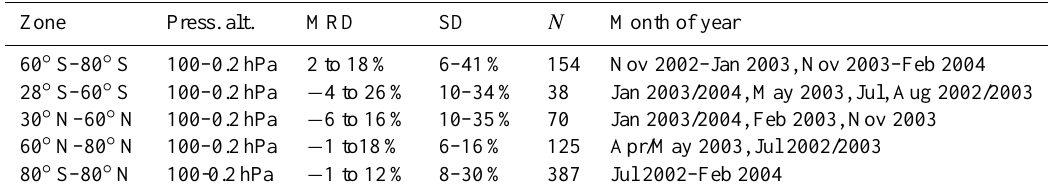
Fig. 13. Mean relative deviation (including the standard error of the mean) of H 2 O profiles as measured by MIPAS and HALOE in the Northern (left) and Southern (right) Hemispheres for different latitude regions (red solid lines) from 60–80 ◦ N (top left), 30–60 ◦ N (bottom left), 28–60 ◦ S (bottom right), and 60–80 ◦ S (top right). Standard deviation (red dotted lines) and mean combined precision (black dotted lines) and systematic errors (black dashed lines) are also plotted. Table 3. Statistics of the MIPAS vs. HALOE comparison of H 2 O profiles for different latitudinal regions (Zone). Statistical results are given for different pressure altitudes (Press. alt.) and only matches within the same air mass are included; mean relative differences (MRD, (MIPAS-HALOE)/HALOE)), standard deviation (SD), and number of collocations ( N ) are also shown. Zone Press.